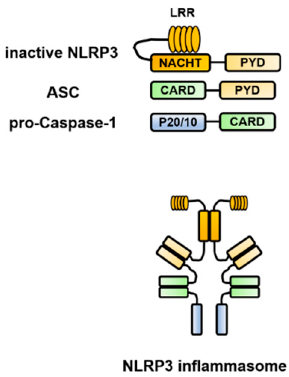
Figure 1. Structure of the NOD-like receptor family pyrin domain-containing 3 (NLRP3) inflammasome. NLRP3 self-polymerizes via the NACHT [NAIP (neuronal apoptosis inhibitory protein), CIITA (MHC class II transcription activator), HET-E (incompatibility locus protein from Podospora anserina) and TP1 (telomerase-associated protein)] domain and binds to apoptosis-associated speck-like protein containing a caspase recruitment domain (ASC) via the pyrin domain (PYD). Furthermore, ASC binds to caspase-1 via the caspase recruitment domain (CARD) to form a complex, which brings the caspase-1 precursors into close proximity to each other, leading to their self-activation and processing of pro-interleukin (IL)-1 β and pro-IL-18 into their mature forms. ASC, apoptosis-associated speck-like protein containing a caspase recruitment domain; CARD, caspase recruitment domain; IL, interleukin; LRR, leucine-rich repeat; NLRP3, NOD-like receptor family pyrin domain-containing 3; NACHT, (neuronal apoptosis inhibitory protein, MHC class II transcription activator, incompatibility locus protein from Podospora anserina, and telomerase-associated protein); PYD, pyrin domain.